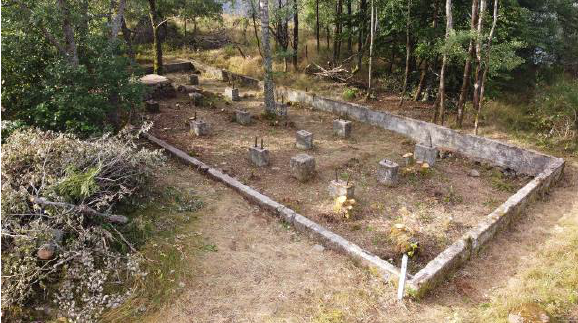
Figure 10 : View of the remains of the canteen hut (A.